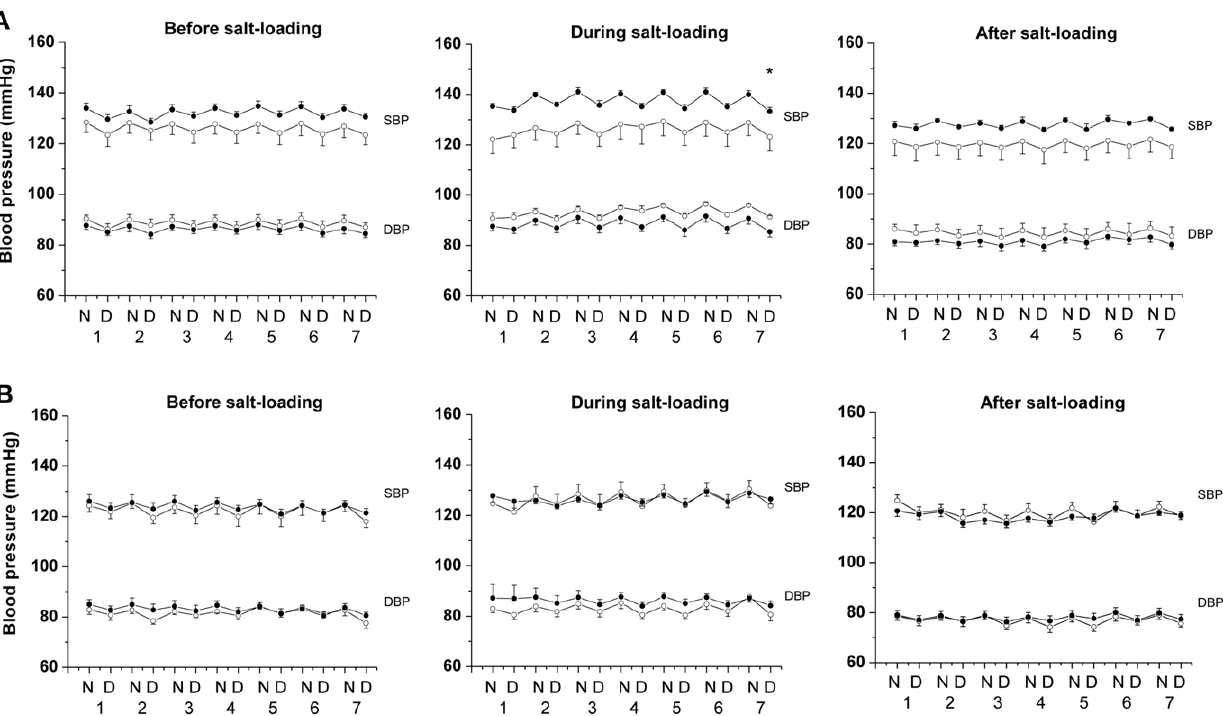
Figure 4. Male offspring of fat-fed dams had an increased pressor response to salt-loading, but not females. SBP and DBP, mmHg, before, during and after salt-loading in (A) male and (B) female offspring of control (open circles) or fat fed dams (closed circles), n=6 per group. *P , 0.05 versus control (night-time; active phase). Error bars represent mean 6 SEM.